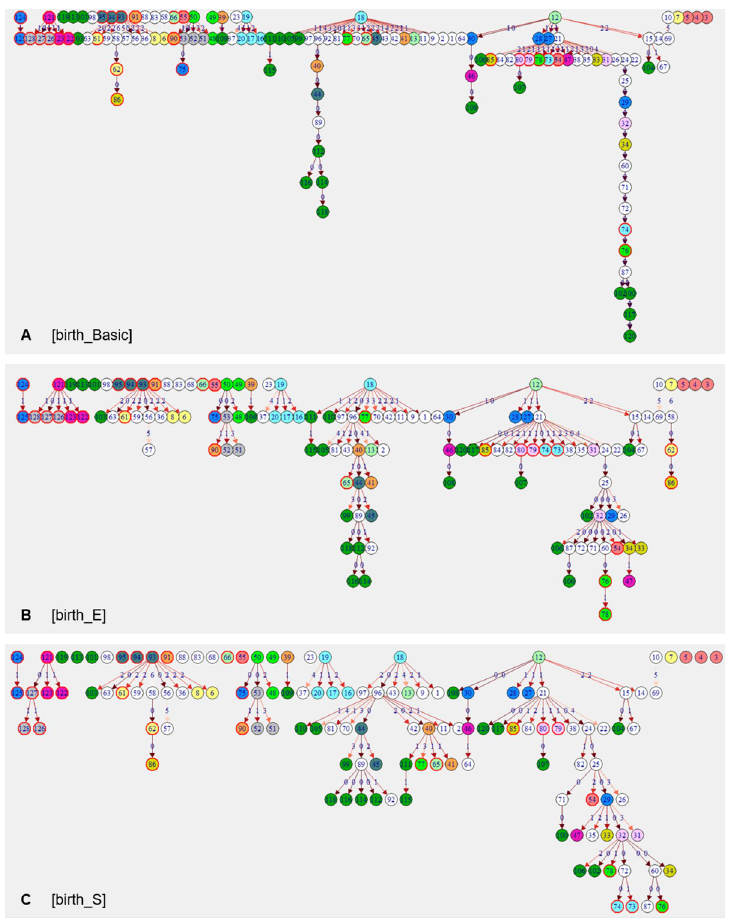
Fig 5. Reconstructed transmission tree of three scenarios (n = 128 isolates). (A) [birth_Basic], (B) [birth_E], (C) [birth_S]. Isolates sampled from the same cow are labelled with successive numbers and are shown in vertices of the same colour and outline. White vertices represent cows with only one isolate. Dark green vertices (labelled 99–120) represent environmental samples. Edge labels and edge colour indicate number of SNPs of difference between ancestor and descendant. For a list of descendants, their ancestors and the pairwise genomic distance, see S2 Table.